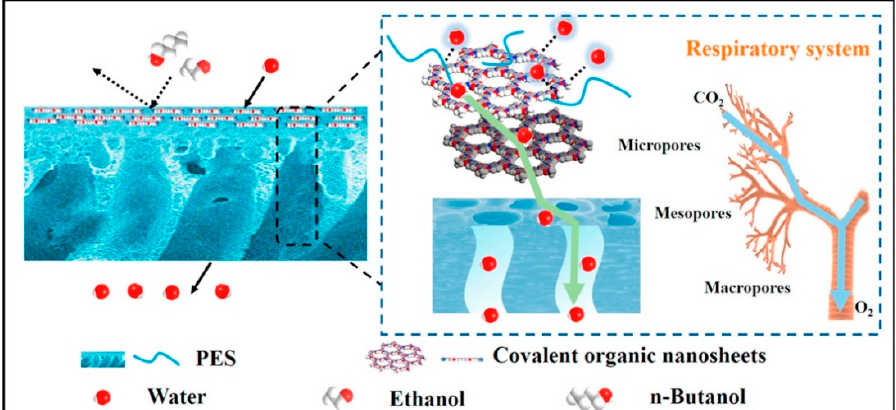
Figure 26. Schematic demonstrating effective water/alcohol separation using hierarchical pore structures made from 2D covalent organic nanosheets. structures made from 2D covalent organic